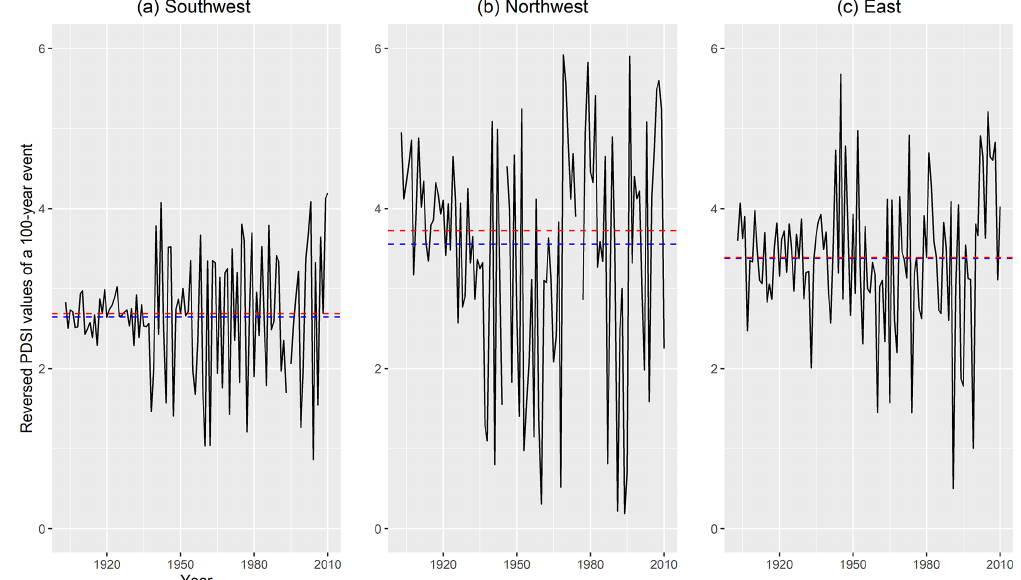
Figure 6. Estimated effective return periods of a 100-year event from the GEV distribution function fitted to the PDSI values in the southwest over 1903 to 2010 with precipitation data as a linear covariate in the location parameter. Variabilities in return periods of 100-year events of the PDSI values become larger over time in all the regions. The horizontal blue line is the mean of the effective return periods, while the red one is its median. Please note that the vertical axis is shown by the reversed values of PDSI values, meaning that a positive value is a drought condition.